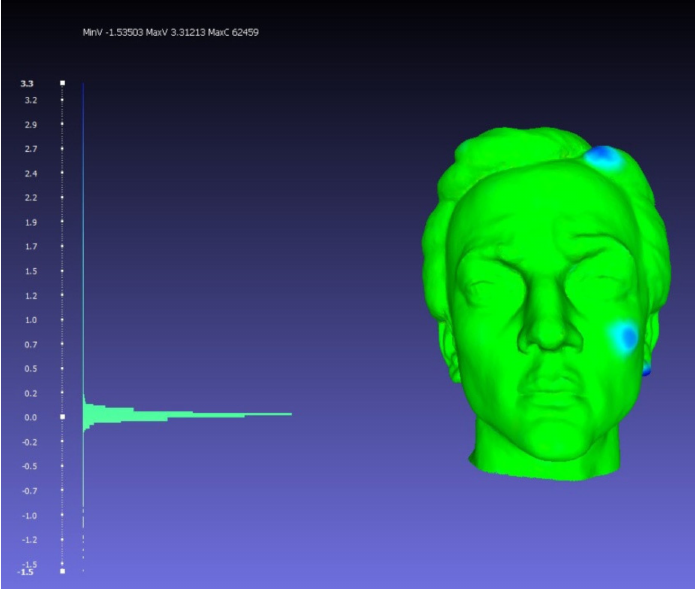
Figure 9. Results of the comparison of models obtained by 3D scanning process in MeshLab